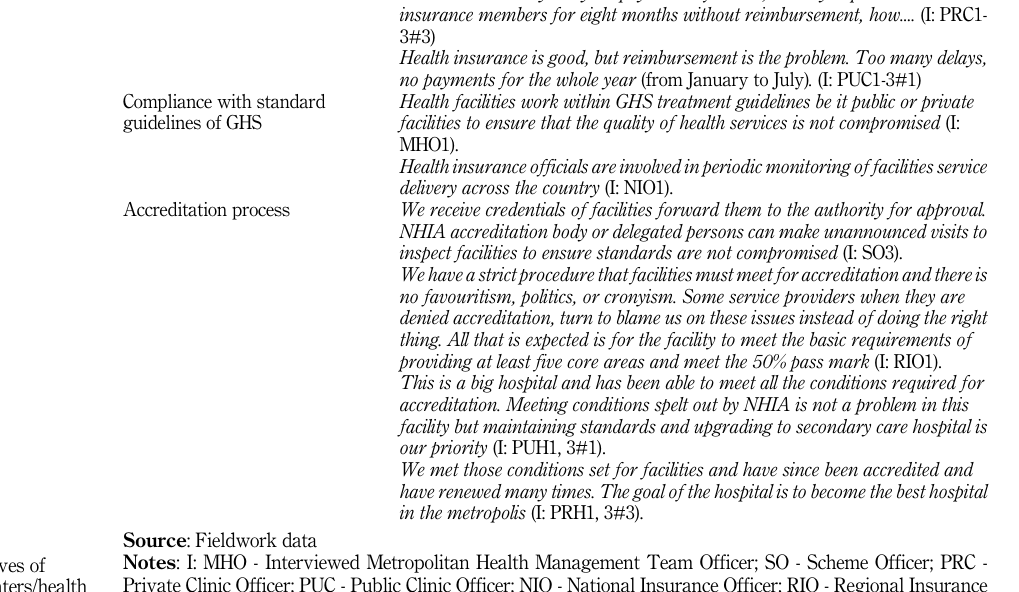
implementers/health service